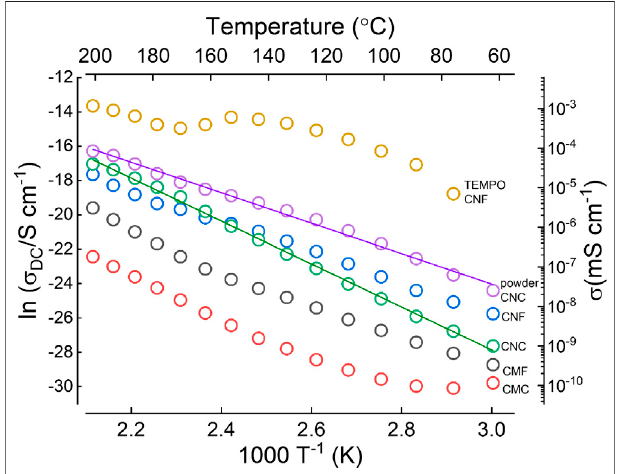
FIGURE 8 | Proton conductivity of BC/Na fi on blend membranes before and after annealing, measured at 30 ° C and 100% RH. The observed trend indicates that when mixed with an ionomer, the conductivity depends on its relative proportion in the composite. Redrawn from Jiang et al. (2015).